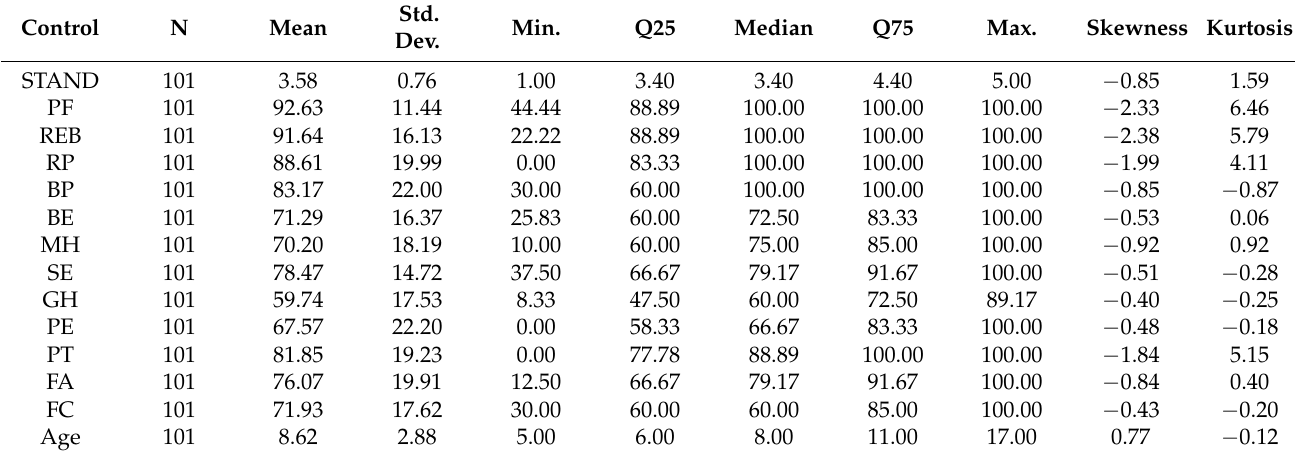
Table 2. Summary statistics—continuous variables for the test group (adenoid